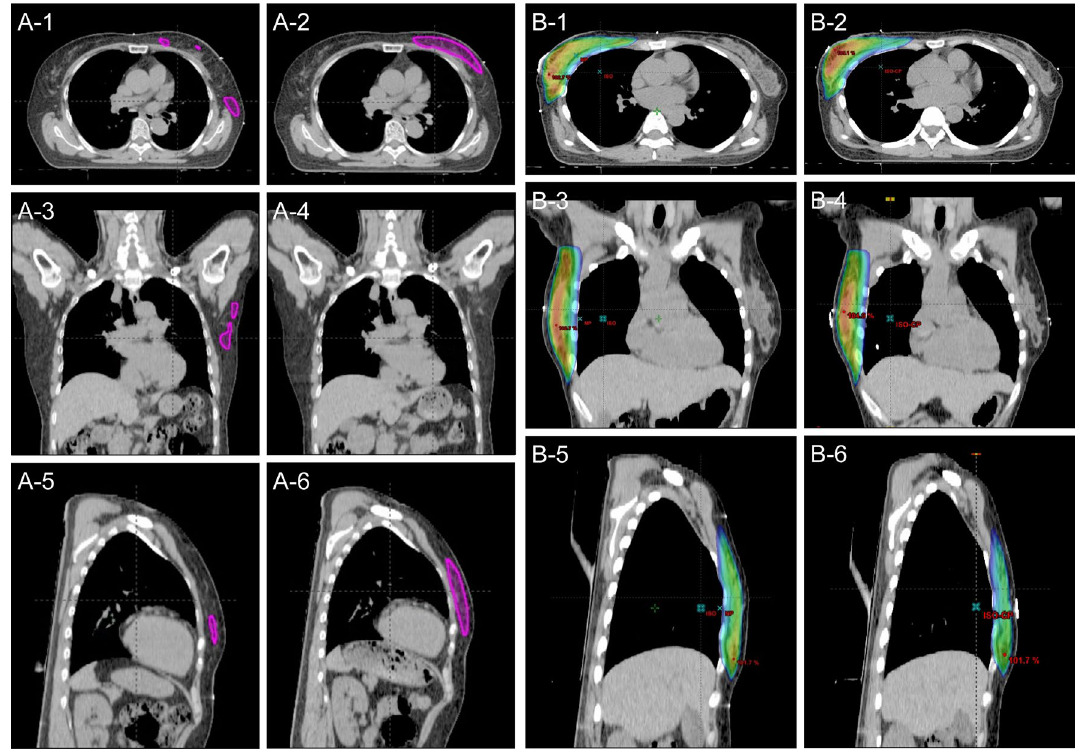
Figure 1. Representative illustration cases. A-1: 103% isodose lines at iCT in patient 1 (axial image), A-2: 103% isodose lines at rCT in patient 1 (axial image), A-3: 103% isodose lines at iCT in patient 1 (coronal image), A-4: 103% isodose lines at rCT in patient 1 (coronal image), A-5: 103% isodose lines at rCT in patient 1 (sagittal image), A-6: 103% isodose lines at rCT in patient 1 (sagittal image), B-1: 95% isodose lines at iCT in patient 2 (axial image), B-2: 95% isodose lines at rCT in patient 2 (axial image), B-3: 95% isodose lines at iCT in patient 2 (coronal image), B-4: 95% isodose lines at rCT in patient 2 (coronal image), B-5: 95% isodose lines at iCT in patient 2 (sagittal image), B-6: 95% isodose lines at rCT in patient 2 (sagittal